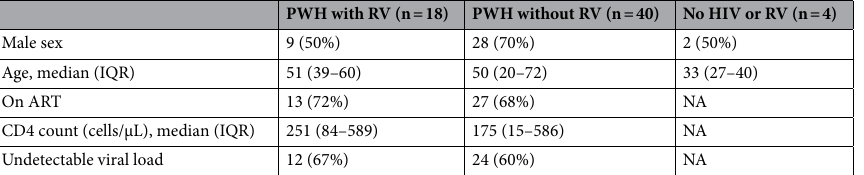
Table 1. Characteristics of cohort, stratified by infectious status. PWH persons with HIV, RV respiratory virus, ART antiretroviral